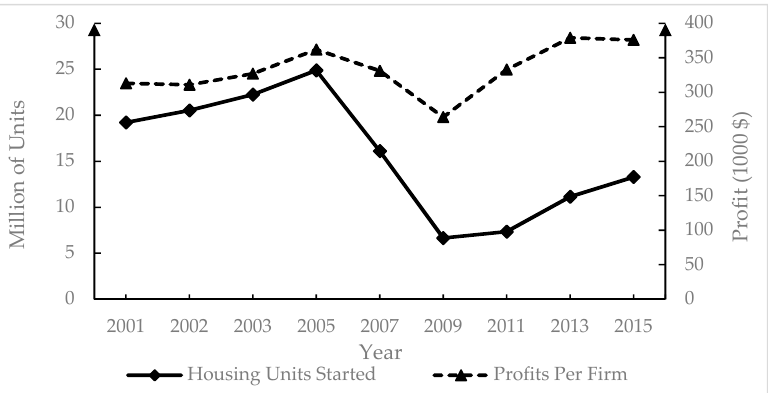
Figure 4. Inflation-adjusted profit per firm and annual, new, privately owned housing units started (2019 Constant-dollar), 2001 to 2015 [38,72].